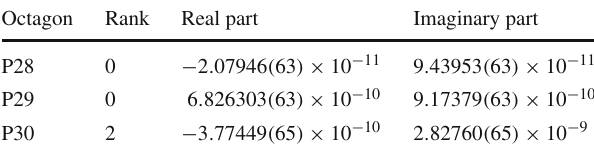
Table 7 Scalar and rank-two tensor